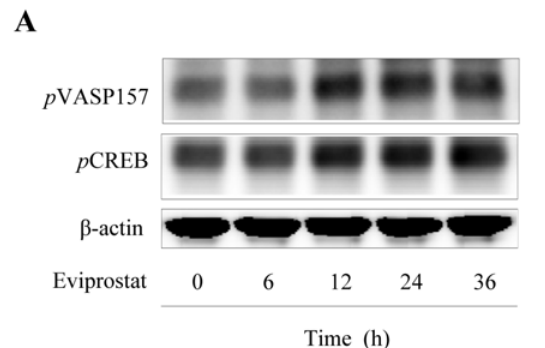
Figure 2. Activation of protein kinase A (PKA) by Eviprostat. ( A ) Time-dependent effects of Eviprostat on phosphorylation of the vasodilator-stimulated phosphoprotein (pVASP) at serine 157 and CREB. Mesangial cells were exposed to 50 μ g/mL Eviprostat or 0.1% dimethylsulfoxide as vehicle control for indicated duration Cellular protein was extracted and subjected to Western blot analysis using specific antibodies for p VASP and p CREB. Equal loading of protein per lane was verified by reprobing the blot with β -actin for loading control. ( B and C ) Densitometric analysis of p VASP and p CREB in A were shown, respectively. The results were normalized to corresponding internal controls and data were presented as induction relative to the basal level in control (mean ± SE, n = 4). # p < 0.01 vs.